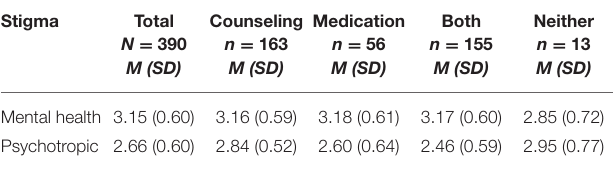
TABLE 1 | Participant characteristics ( N = 390). TABLE 2 | Participants’ stigma scores by treatment preferences.